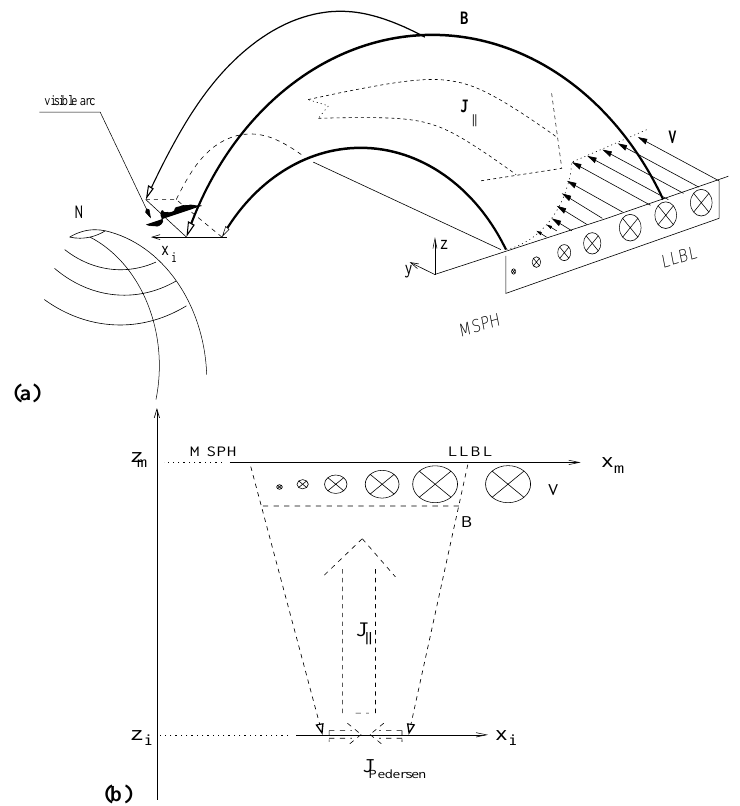
Fig. 1. Diagram illustrating the geometry considered to study the coupling between a sheared flow LLBL and the postnoon/evening iono- sphere. (a) A schematic 3-D view of the magnetospheric dusk flank; (b) A simpler, conical geometry has been adopted to describe a flux tube extended from lower/ionospheric altitudes ( z i ) to upper/magnetospheric level ( z m ). The upper boundary of the flux tube coincides with a sector that includes the sheared flow layer at the interface between the LLBL and the magnetospheric dusk flank (MSPH). The sheared flow layer is described by a TD and plays the role of an auroral generator, as explained in the text. The velocity profile is illustrated by circles whose radius is proportional to the local value of the bulk velocity; the velocity is oriented anti-sunward, along the y-axis, into the page (adapted from Echim et al.,